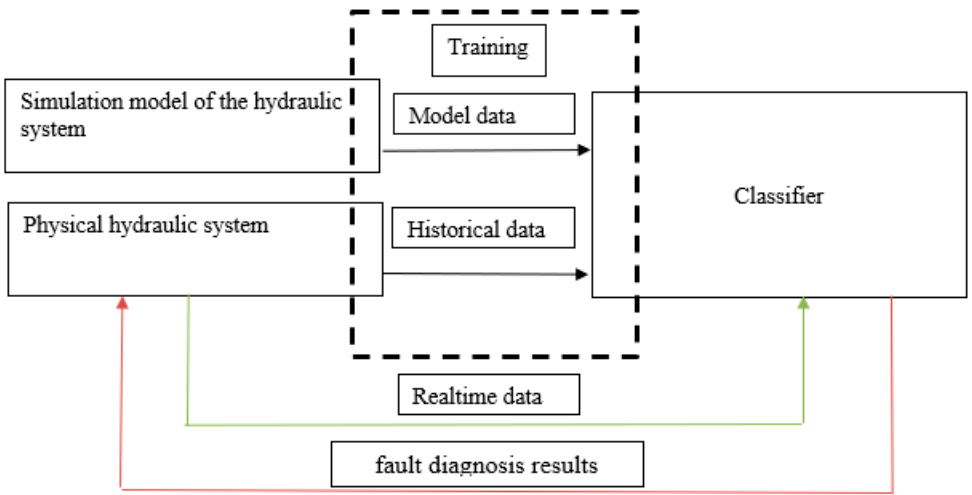
Figure 1. Architecture of the proposed intelligent fault diagnosis system.